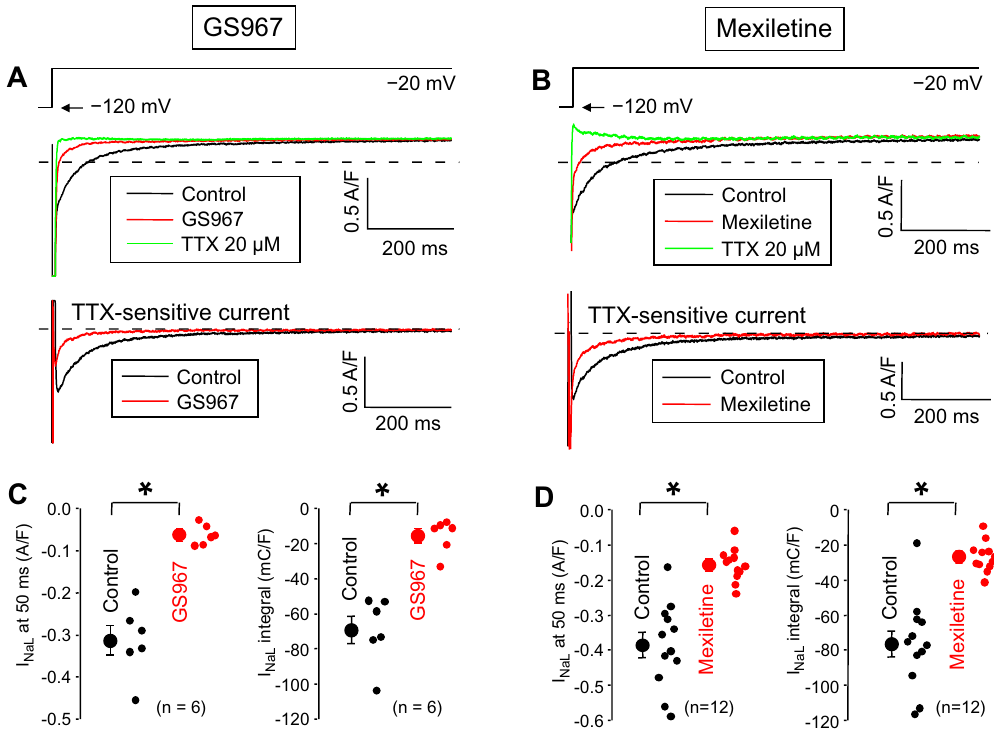
Figure 1. Effects of 1 µM GS967 ( A , C ) and 40 µM mexiletine ( B , D ) on I NaL under conventional voltage clamp conditions using test pulses of 2 s duration clamped to −20 mV from the holding potential of −120 mV. At the end of each experiment the cells were superfused with 20 µM TTX to dissect the remaining I NaL . Dashed lines indicate zero current level. ( A , B ) Representative superimposed analogue records. ( C , D ) Average I NaL densities (measured at 50 ms) and integrals (measured from 20 ms to 2 s). Symbols and bars are mean ± SEM, small dots represent individual data, numbers in parentheses indicate the number of myocytes studied, asterisks denote significant differences between data of the pre-drug control and the GS967- or mexiletine-treated